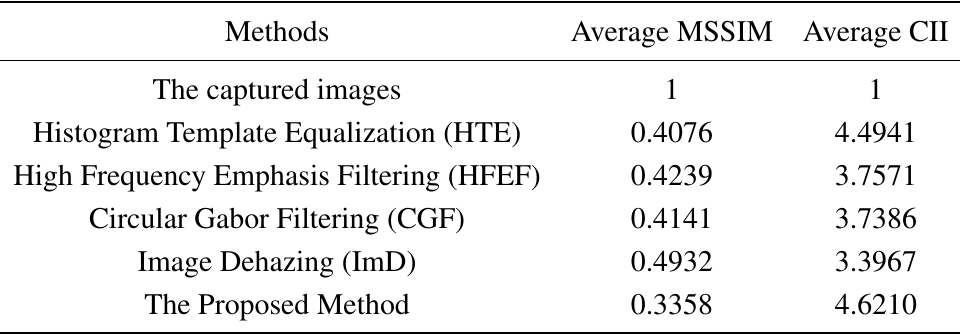
Table 1. Quantitative evaluation of different enhancement